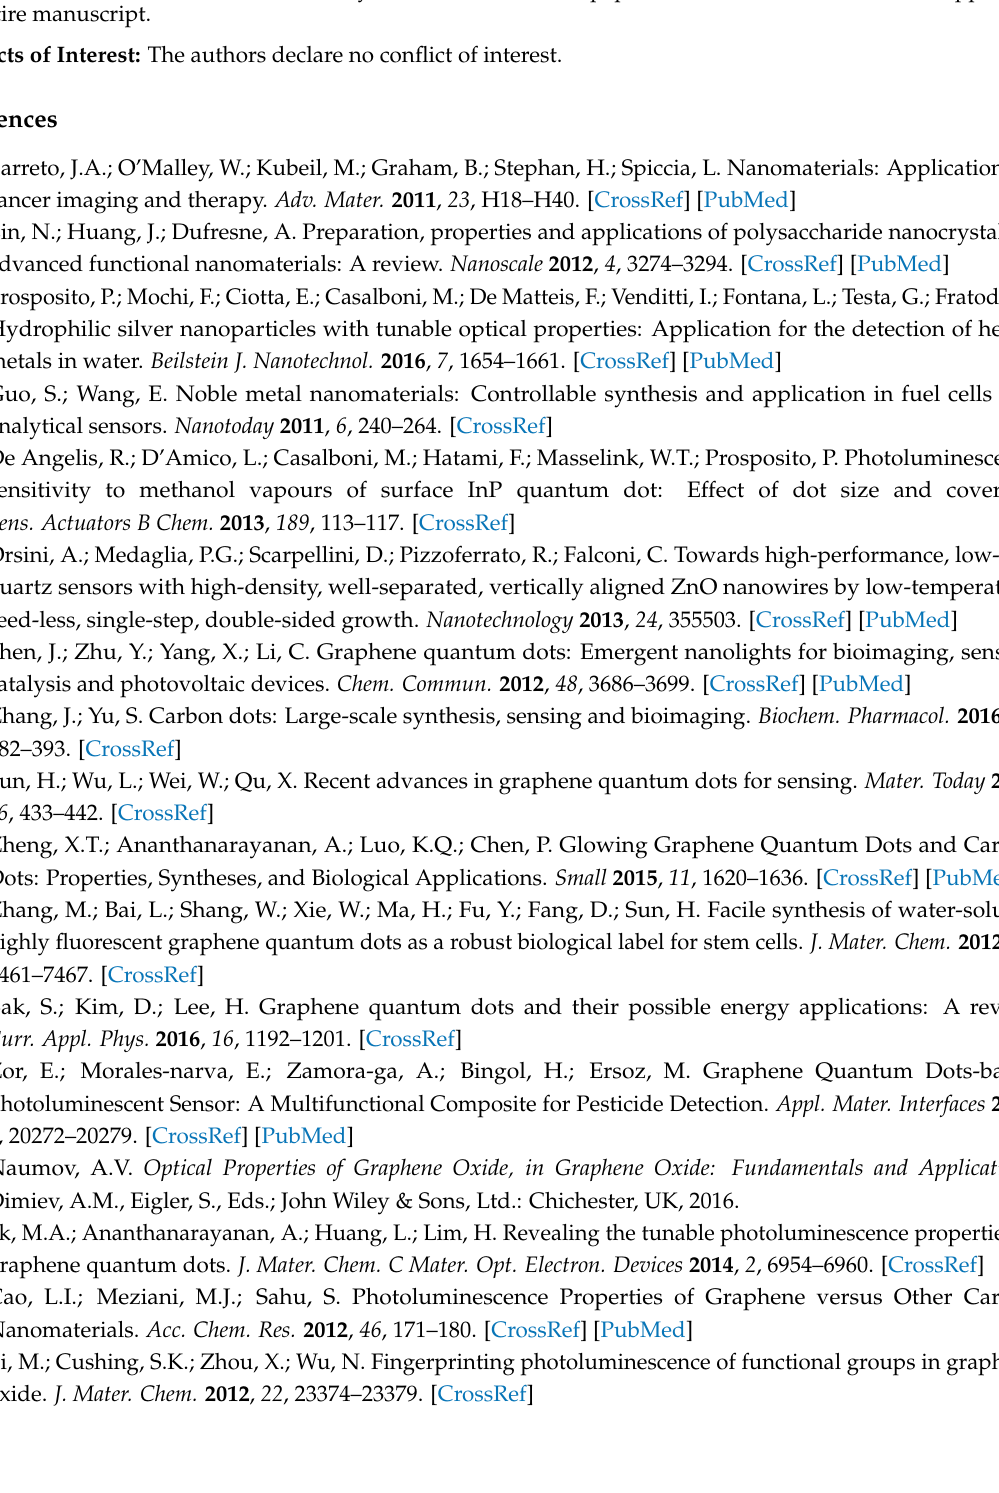
Figure S10. Photograph of the UFQDs solution taken 6 h after the addition of 100 µ M Cu 2+ (1), As(III) (2) and Pb 2+ (3). Figure S11. Emission spectra of the UFQDs reference solution in the absence (black line), in the presence (red line) of 100 µ M Pb 2+ and in the presence of the Pb 2+ - quenched solution (blue